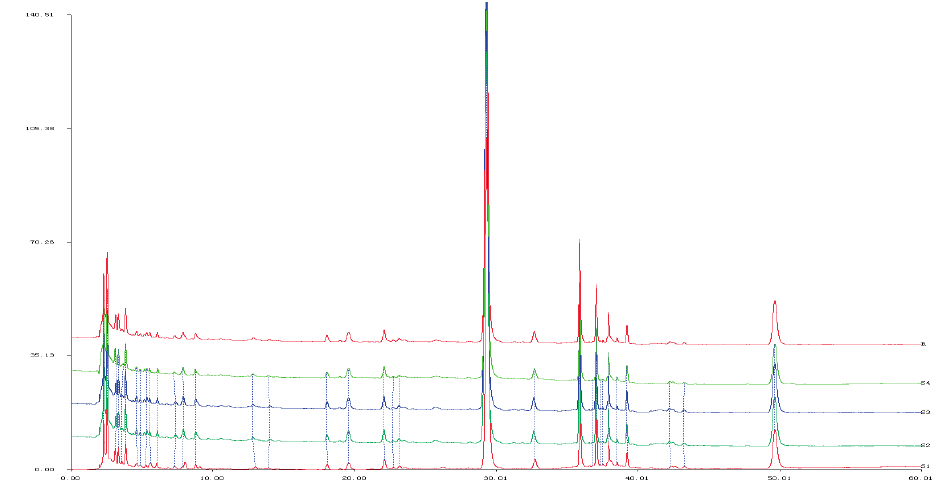
Figure 4. The superposed graphs of HPLC fingerprint of 4 Fenge water decoctions. The HPLC referential fingerprint from (R).